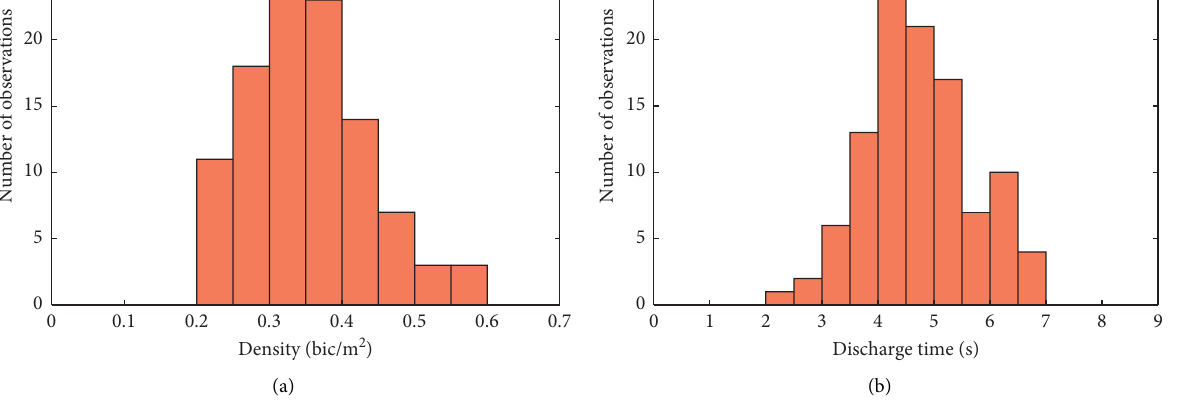
Figure 4: Frequency distributions. Table 1: Pearson correlation matrix.